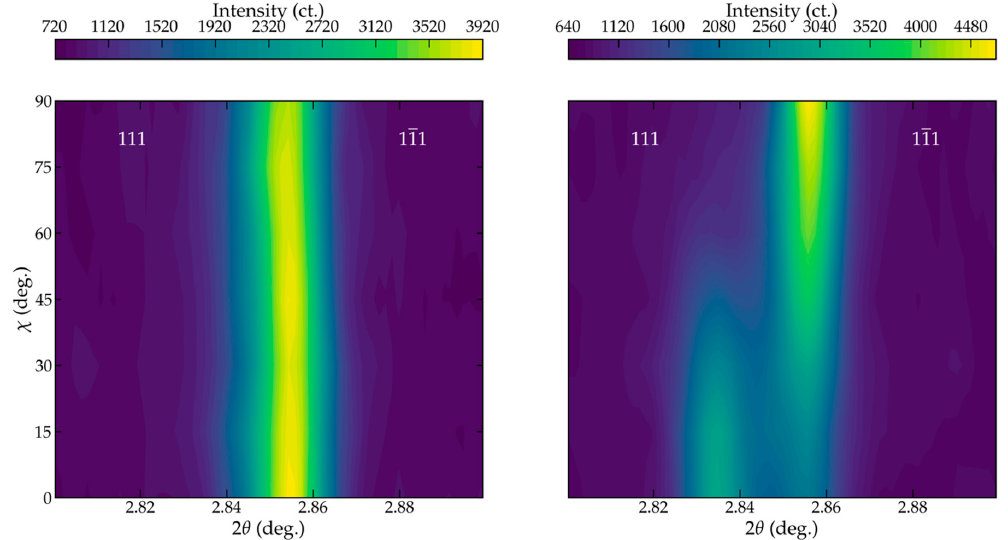
Figure 5. Measured angular dependent diffraction data for BNT before ( left ) and after ( right ) application of strong electric fields (8 kV/mm) for 1 s. Data are plotted vs. the out-of-plan angle χ , with 0 and 90 representing data measured parallel and perpendicular to the applied electric fields, respectively. Electric poling drives substantial ferroelastic domain wall motion with aligns the 111 lattice planes in the field direction ( χ of